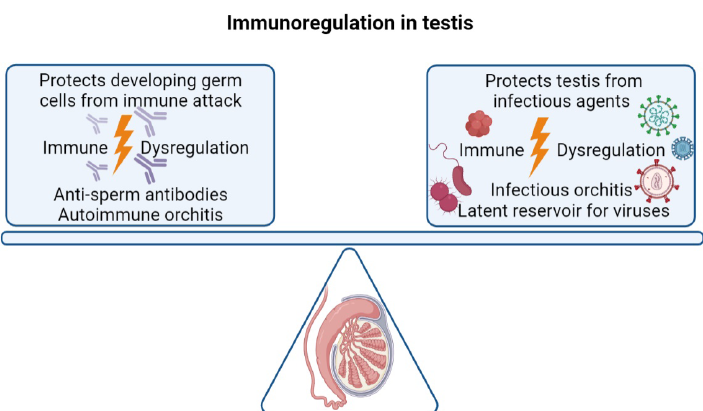
Figure 2. The balancing act of immune system in the testis. The immune system has to protect the developing germ cells from illiciting an immune response. When the tolerogenic mechanisms in the testis are dysregulated, it can lead to the formation of anti-sperm antibodies and autoimmune orchitis. On the other hand, the immune system must protect the testis from external pathogenic threats. When these mechansims fail, it can lead to infectious orchitis, and the testis can become a latent reservoir for viruses like HIV, ZIKV and